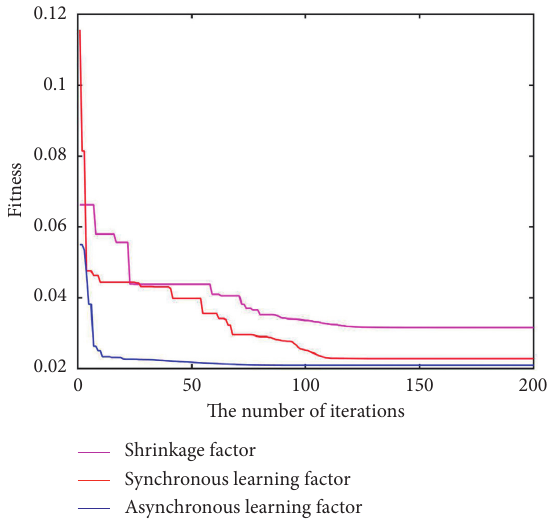
Figure 7: Comparison of fitness curve of three PSO